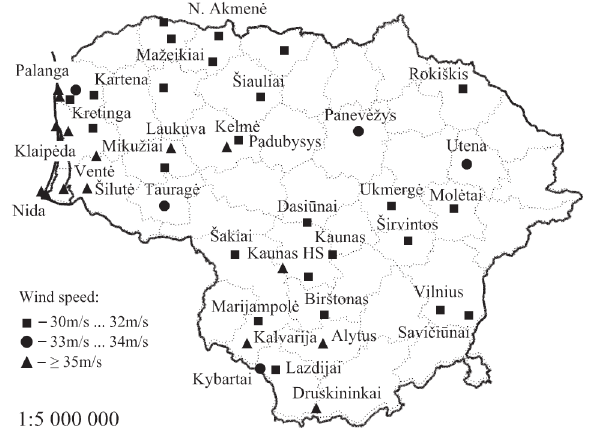
Fig. 1. Map showing the network of Lithuanian weather stations with 10-min wind speeds of at least 30 m/s recorded in 1962– 2005 (the geographic coordinates of the stations were provided by Lithuanian Hydrometeorological Service, http://www.meteo.lt/)